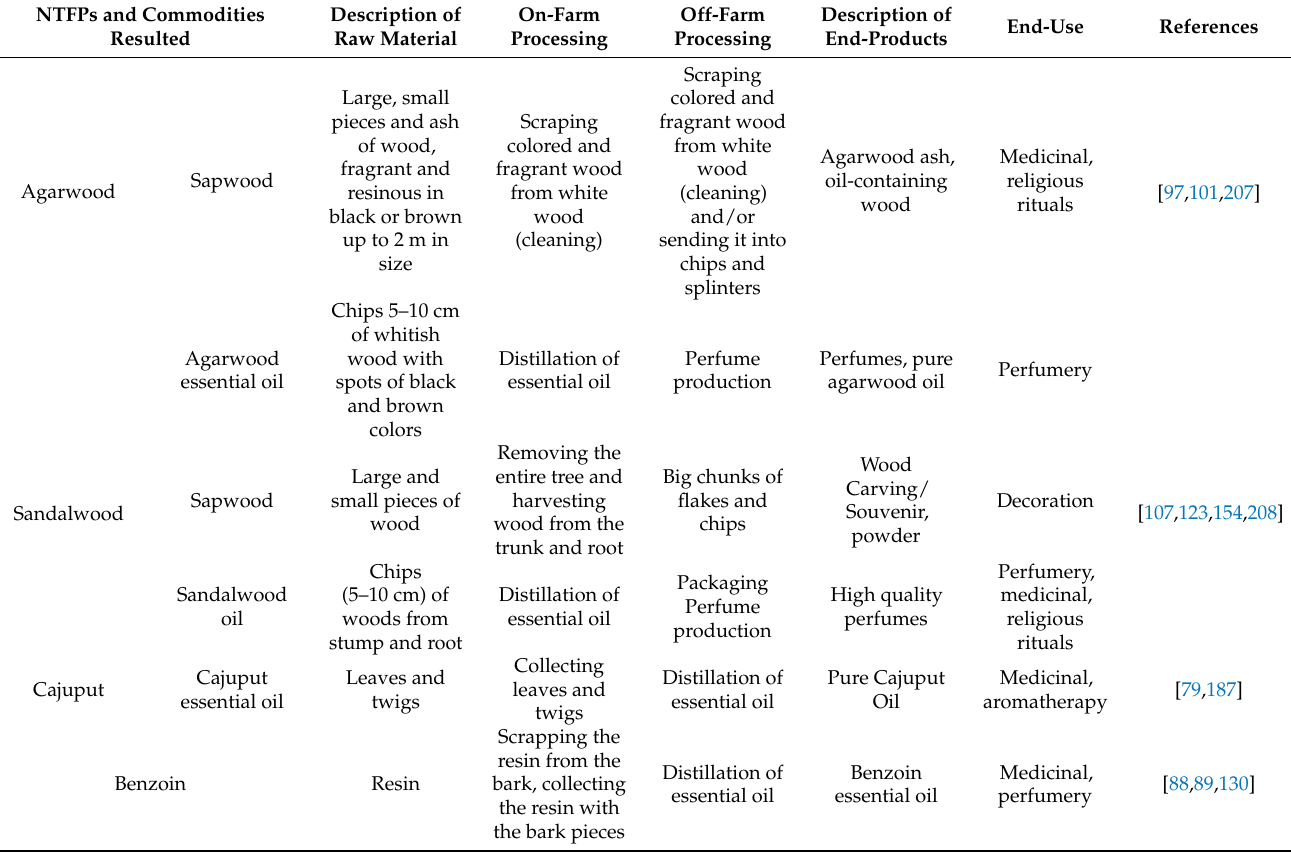
Table 2. Description of the four Non-Timber Forest Products value